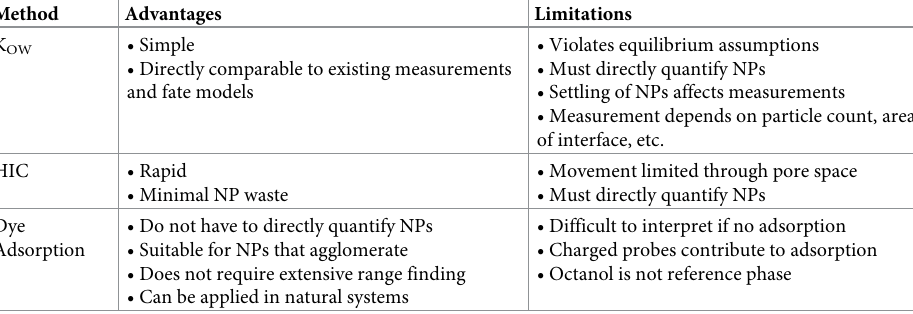
Table 2. Comparison of methods to evaluate NP